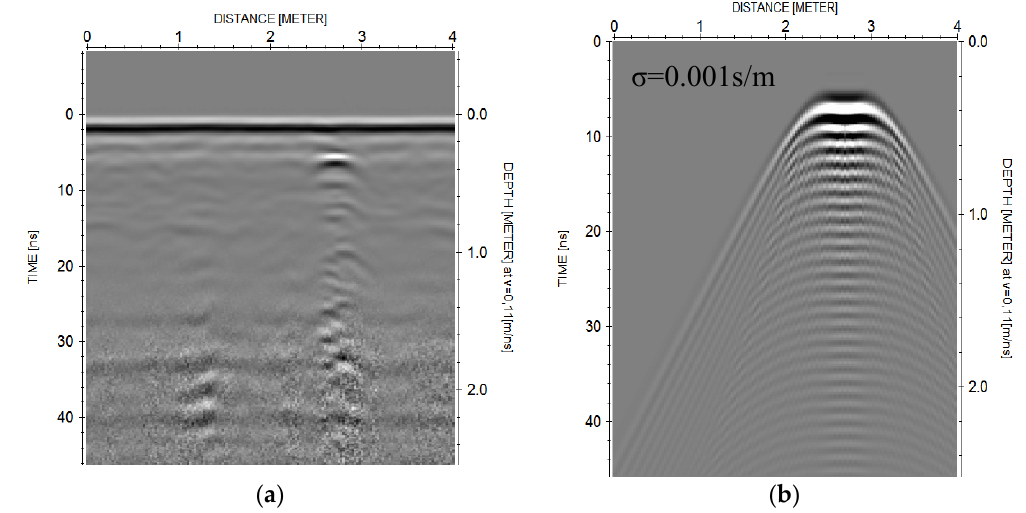
Figure 8. ( a ) Result obtained by GPR, ( b ) result obtained by simulation.